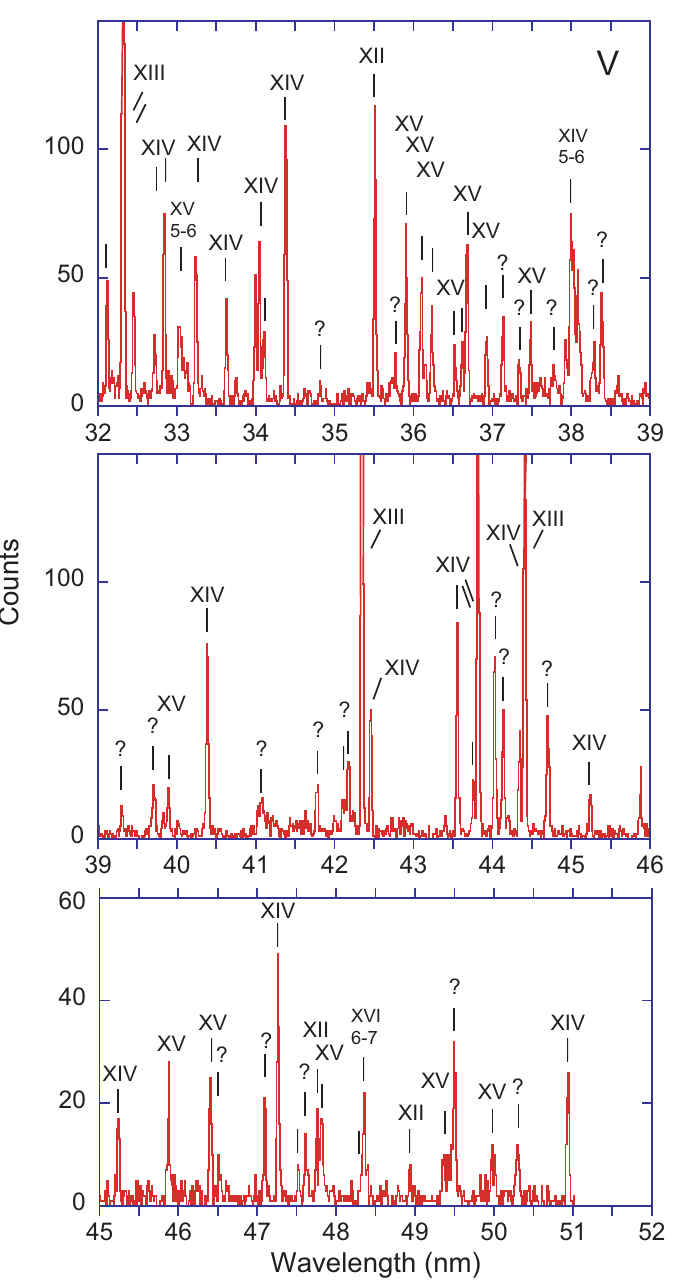
Figure 10. Beam-foil spectra of V at an ion beam energy of 30MeV. Observation at the foil. Line width (FWHM) 0.03nm. The strongest lines are identified by the spectrum